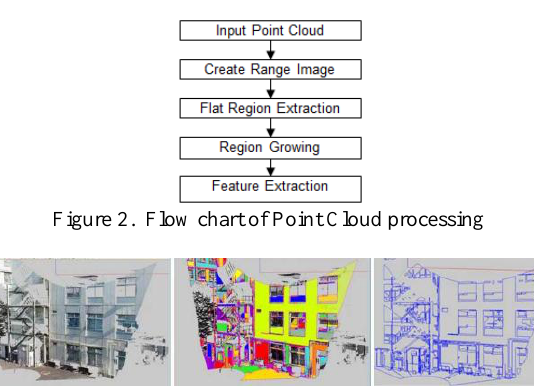
Figure 3. Left: Point Cloud data, Middle: Segmentation result, Right: 3D Edge detection